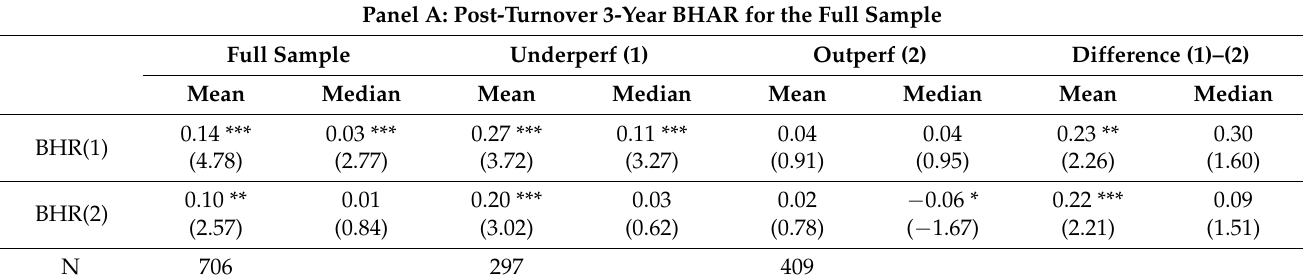
Table 11. Postevent BHAR with alternative benchmarks of expected returns for under- and outperforming CEO classifications. Panel A: Post-Turnover 3-Year BHAR for the Full Sample